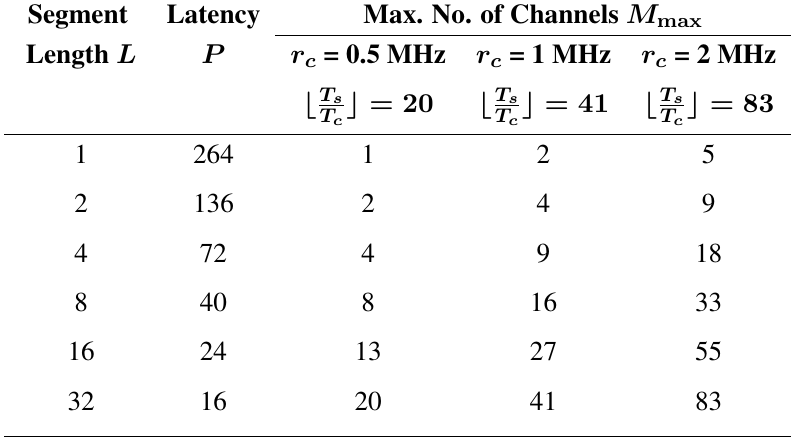
Table 5. The latency P of the GHA circuit and the maximum number of channels M various segment lengths L and clock rates r gating. The sampling rate of spike trains is r of samples between the peak of successive spikes from the same channel is assumed to be Q = 16 .